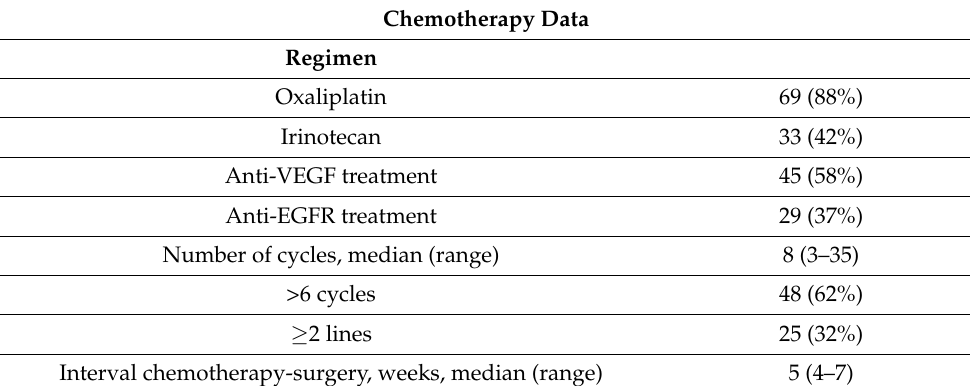
Table 1. Details of chemotherapy and pathology